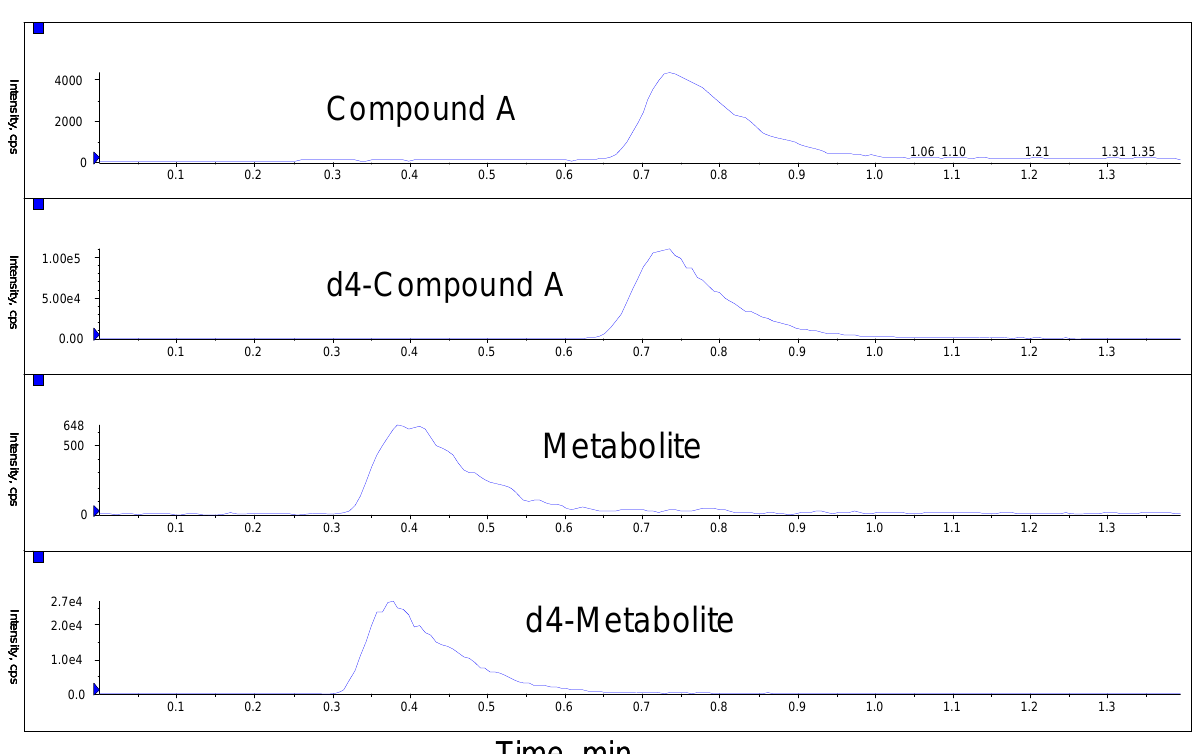
Figure 3. Representative ion chromatograms of an LLOQ sample from the rabbit whole blood